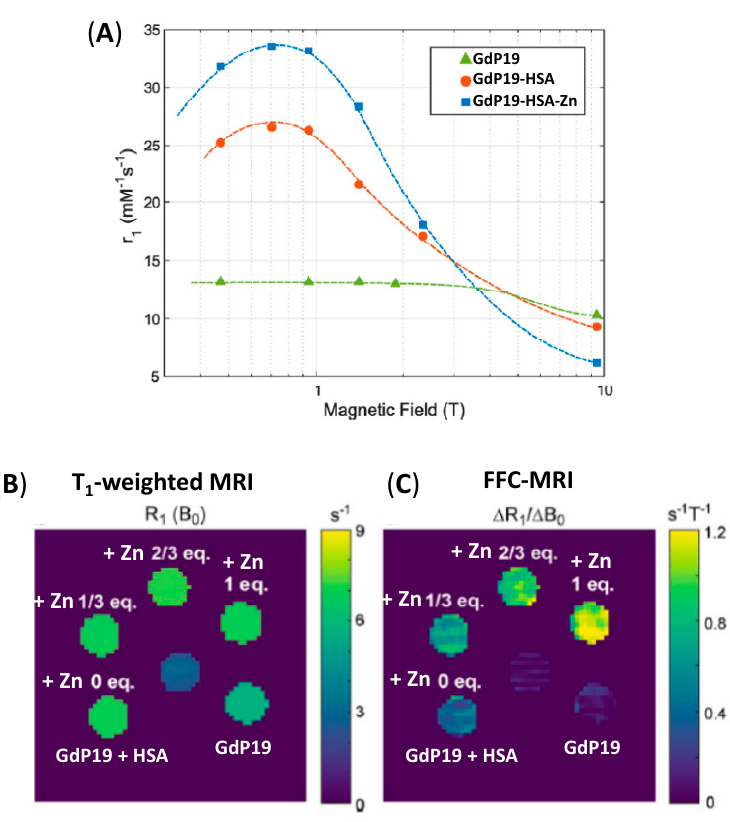
Figure 13. ( A ) 1 H NMRD profile of GdP19 alone, in the presence of human serum albumin (HSA), and HAS + Zn 2+ ; ( B ) R 1 map obtained at 2.89 T, the nominal field strength of the MRI system; ( C ) Δ R 1 / Δ B 0 map obtained from subtracting R 1 maps at 2.99 T and 2.79 T. Adapted with permission from Ref [55]; published by Wiley-VCH, 2018.